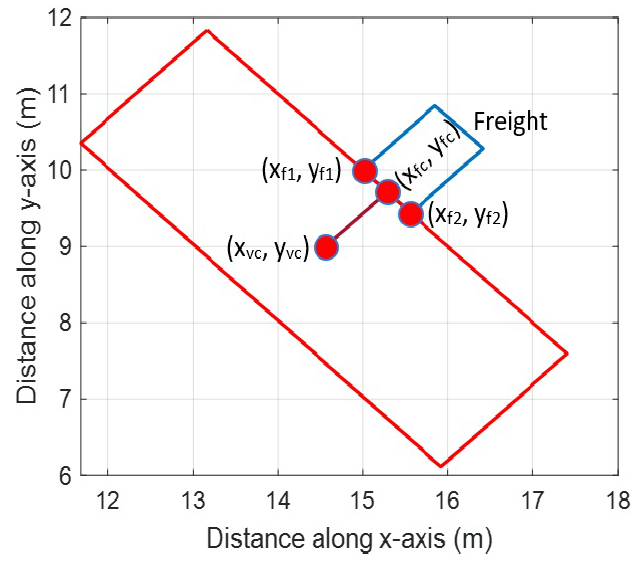
Figure 8. Point definition for parking